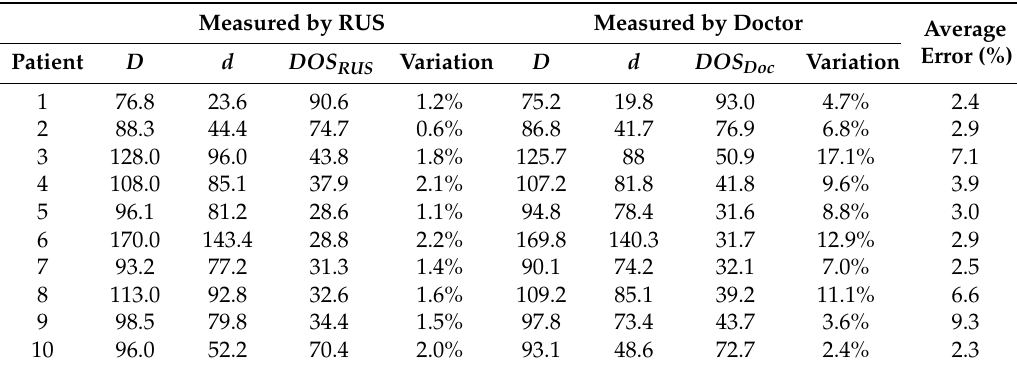
Table 2. Comparison of DOS measurement by RUS and